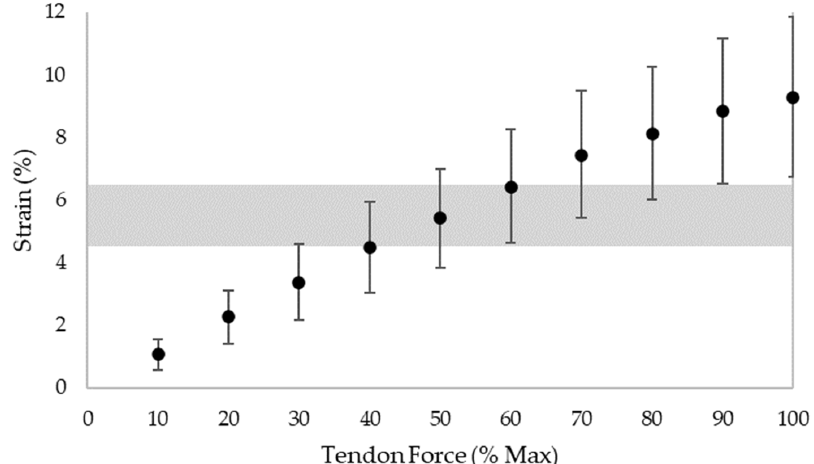
Figure 2. Relationship between tendon force (i.e., % MVC) and strain in 20 healthy individuals. The transparent gray area indicates the strain range proposed to be optimal for positive tendon adaptation (4.5% to 6.5% strain [42–44]). Data points represent means and error bars denote standard deviation. Data in this graph was obtained from [147].